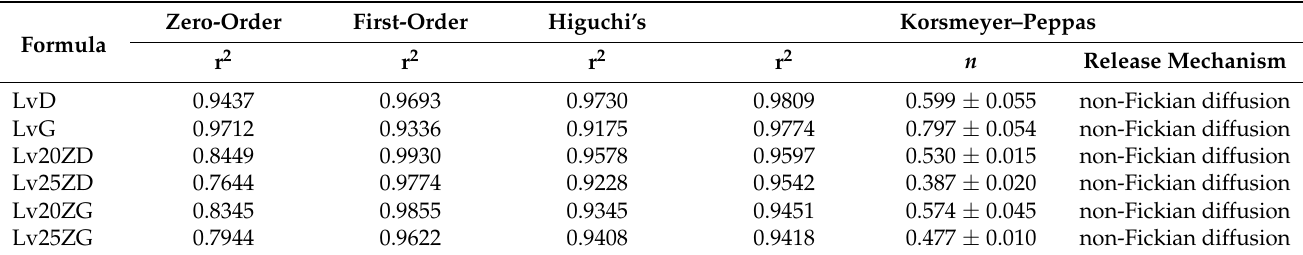
Table 3. The regression coefficient (r 2 ) value and diffusion exponent value ( n ) obtained from the drug release profile of Lv-loaded zein-based ISGs fitting to different mathematical